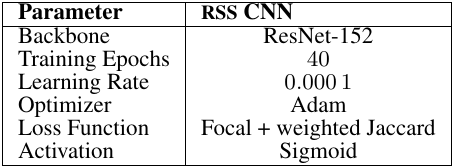
Table 1. Model and training parameters of the used CNN